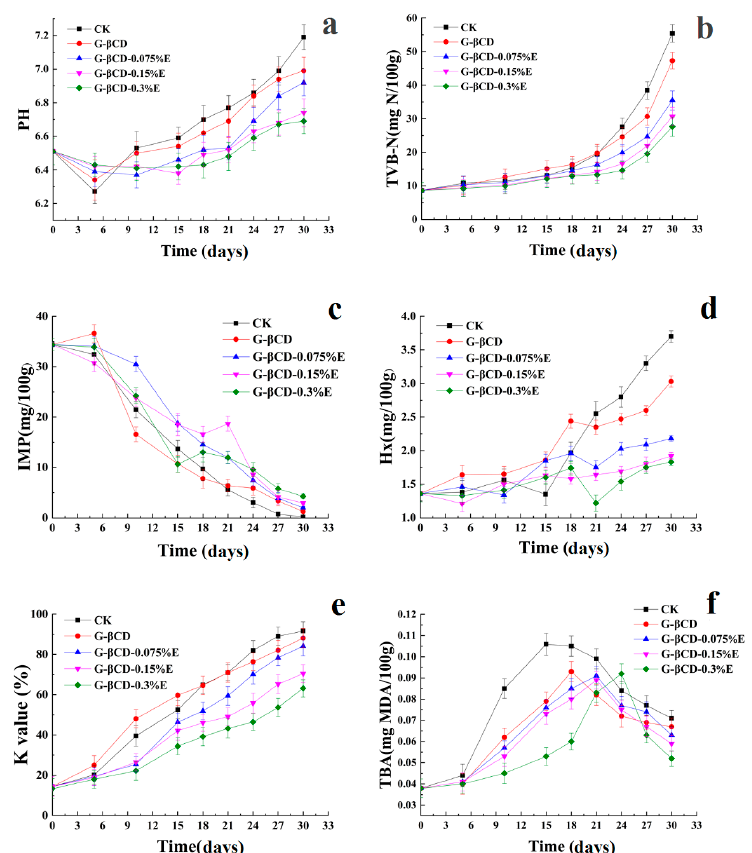
Figure 2. Changes in pH values ( a ), total volatile basic nitrogen values (TVB-N, b ), inosine 5 ′ -monophosphate (IMP, c ), hypoxanthine (Hx, d ), K value ( e ), and Thiobarbituric acid (TBA, f ) of Chinese seabass during superchilling storage at − 0.9 °C. (CK: uncoated; G- β CD: gelatin- β -cyclodextrin coating without eugenol; G- β CD-0.075%E: gelatin- β -cyclodextrin coating with 0.075% eugenol; G- β CD-0.15%E: gelatin- β -cyclodextrin coating with 0.15% eugenol; G- β CD-0.3%E: gelatin- β -cyclodextrin coating with 0.3% eugenol).